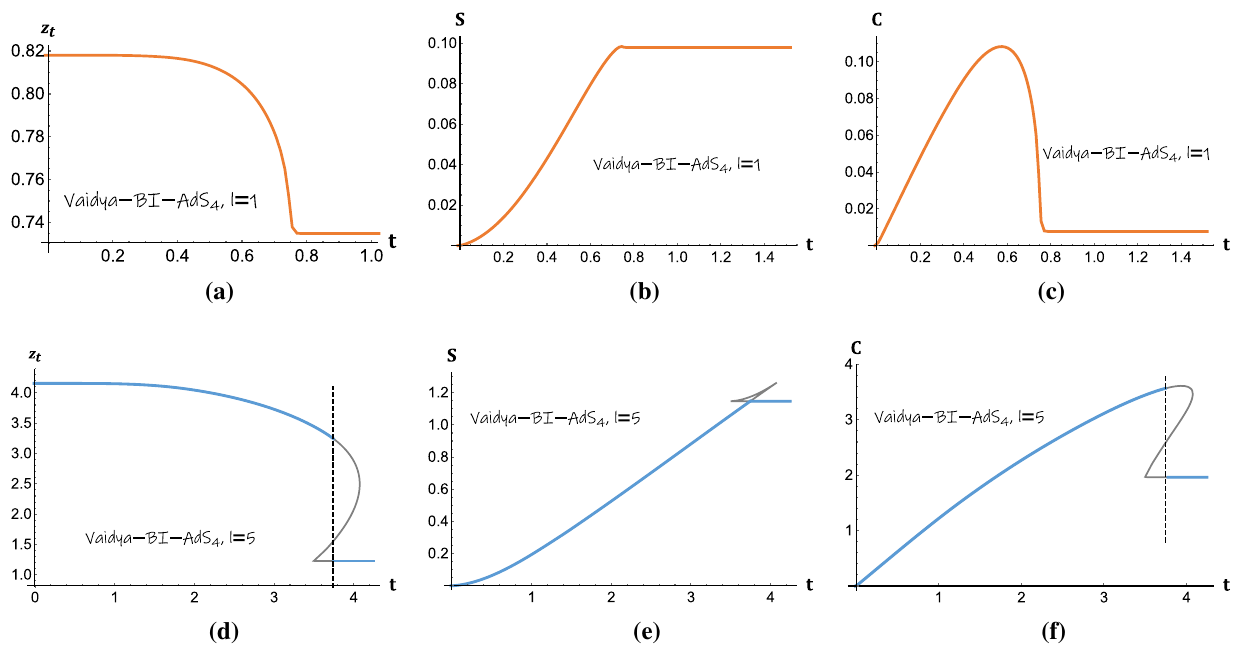
Fig. 1 Two distinct patterns of the evolution of HEE and subregion complexity. The figures on the top display a continuous pattern with l = 1, while the figures at the bottom display a discontinuous pattern with l = 5. The dashed lines denote the critical time for the transition t c = 3 .